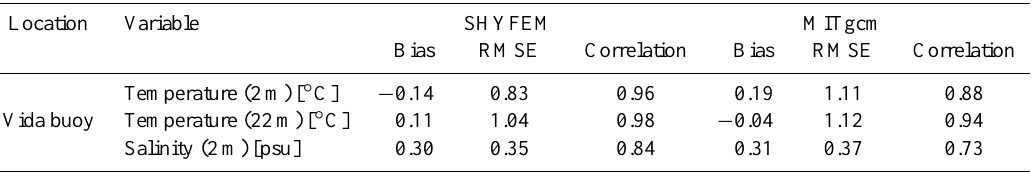
Table 1. Statistical analysis of simulated water temperature and salinity time series computed at the Vida buoy. Analyses provided are the difference between mean of observations and simulations (Bias), the root mean square error (RMSE), and the correlation.